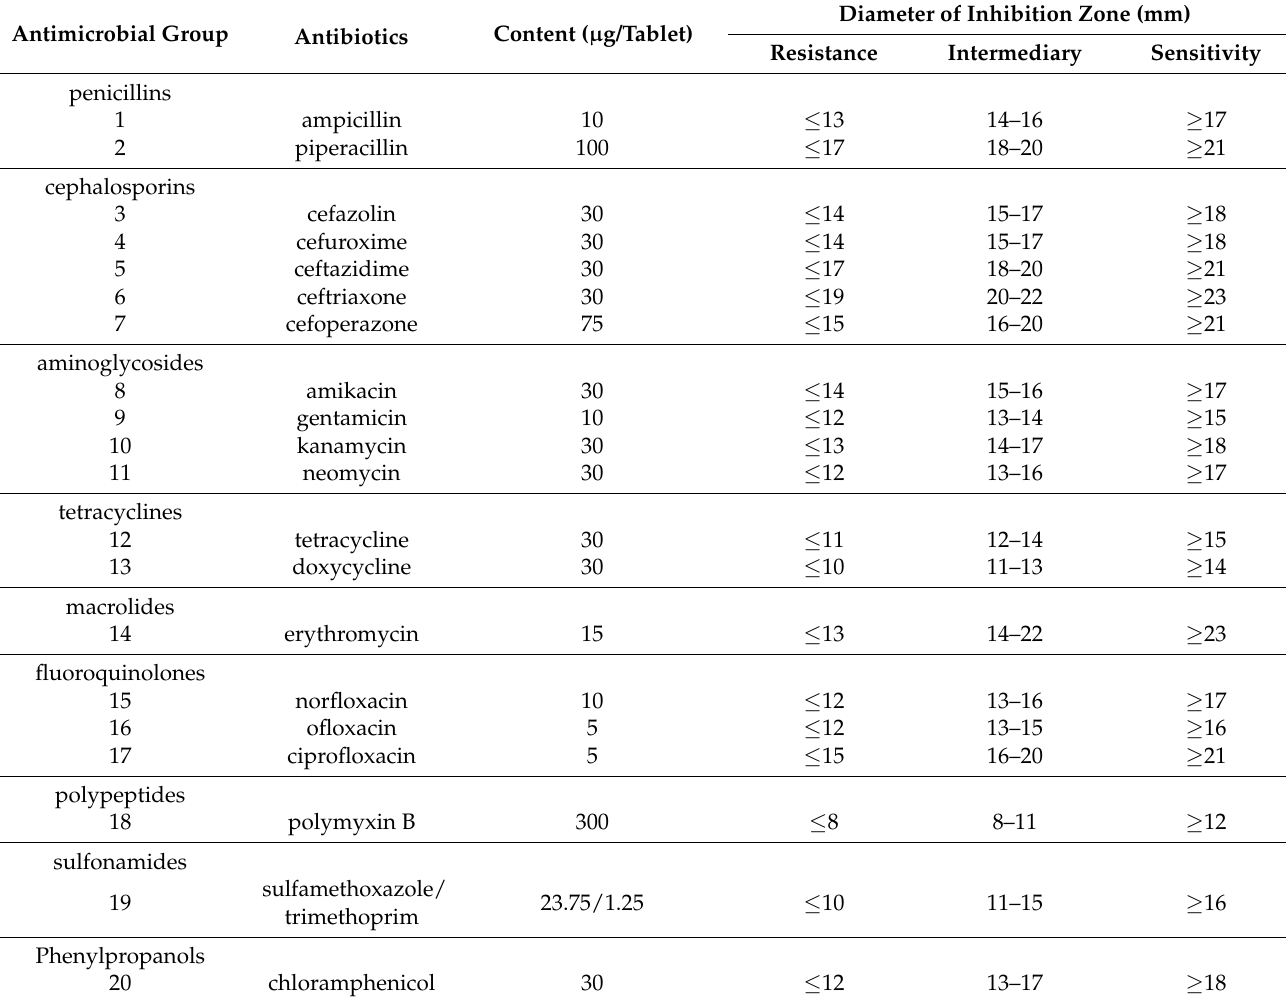
Table 1. Antibiotics for drug sensitivity determination and judgment